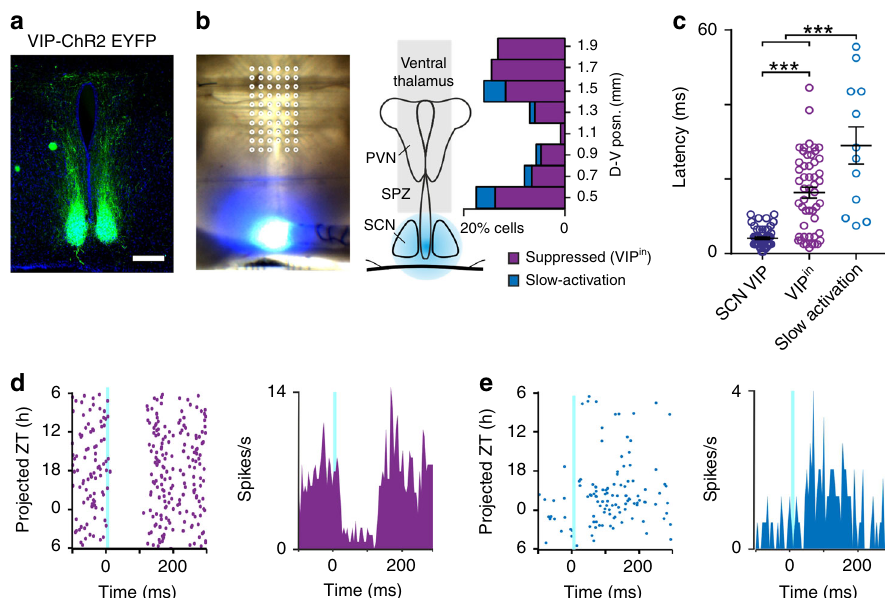
Fig. 2 Optogenetic identi fi cation of VIP in cells in regions receiving SCN input. a Immunohistochemical ampli fi cation of ChR2-EYFP expression from a VIP-ChR2 mouse, showing terminal fi elds of the VIP neurons lying within the SPZ, PVN and ventral thalamus. b Light microscope images of a VIP-ChR2 brain slice on the pMEA with overlaid recording site locations (left) and schematic showing the percentage of identi fi ed cells displaying suppressions or slow-activation following 10 ms light fl ashes (right; n = 51 and 12 cells, respectively from 718 isolated neurons). c Response latencies for SCN VIP cells and SPZ, PVN and ventral thalamic cells exhibiting optogenetic-driven suppressions (VIP in ) or slow-activation. Data analysed by multilevel mixed-effects linear model (F 2,44.89 = 18.0, P < 0.001) with Tukey post-tests. d , e Flash evoked single unit spike rasters over 24 h (left) and mean response histograms (right) for representative cells showing optogenetic-driven suppression ( d ) or slow-activation ( e